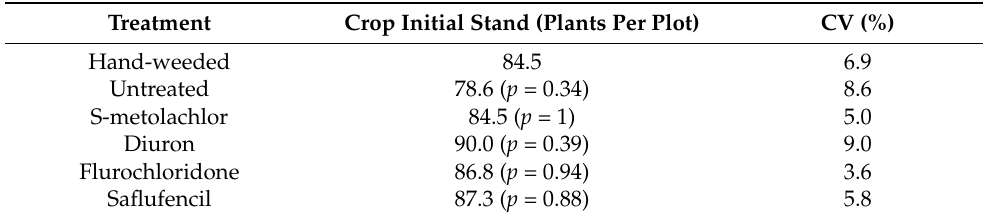
Figure 1. Effect of PRE herbicides application on moringa and weeds during the 2019 season. ( A ) Moringa fresh weight. Data are mean ( n = 6). Differences between treatments were analyzed by the Dunnet test in comparison with hand weeded control. ( B ) Weed cover, and ( C ) weed biomass. Different letters indicate a significant difference according to the Tukey-HSD test. Treatments included: hand weeded control (hwc), untreated control (utc), S-metolachlor (met), diuron (diu), flurochloridone (flu), and saflufencil (saf). Table 1. Pre-emergence herbicide application effect on moringa initial crop stand. Differences between treatments were analyzed by the Dunnet test in comparison with hand weeded control, and the coefficient of variance (CV).